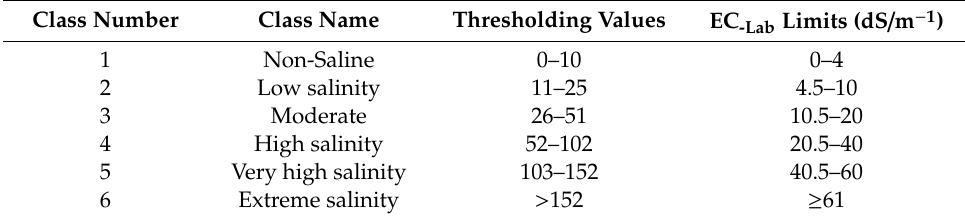
Table 2. Thresholding values and EC -Lab limits for the considered soil salinity